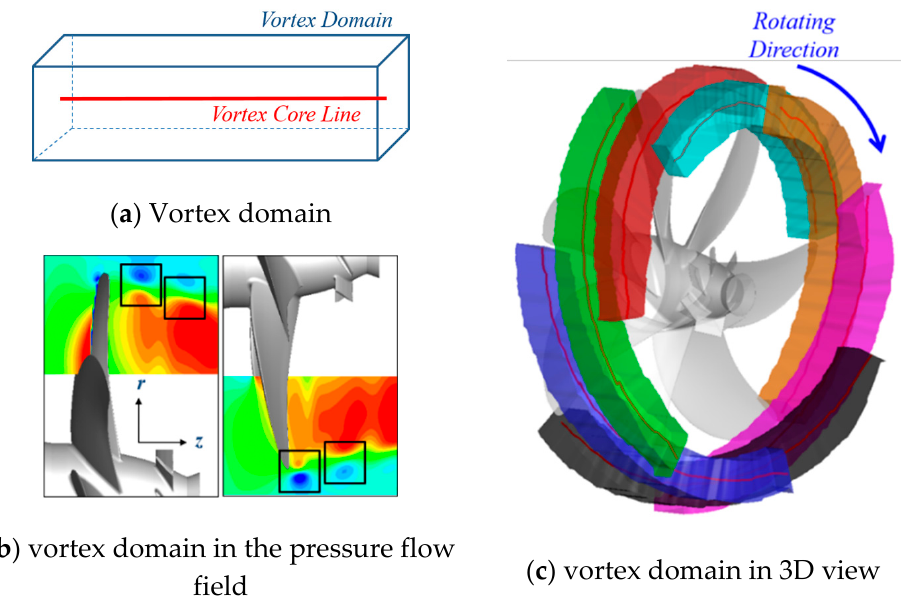
Figure 16. The regions of vortex modeling: ( a ) diagram of the vortex domain; ( b ) the vortex domain in the pressure flow field; ( c ) the vortex domain from the three-dimensional viewpoint.